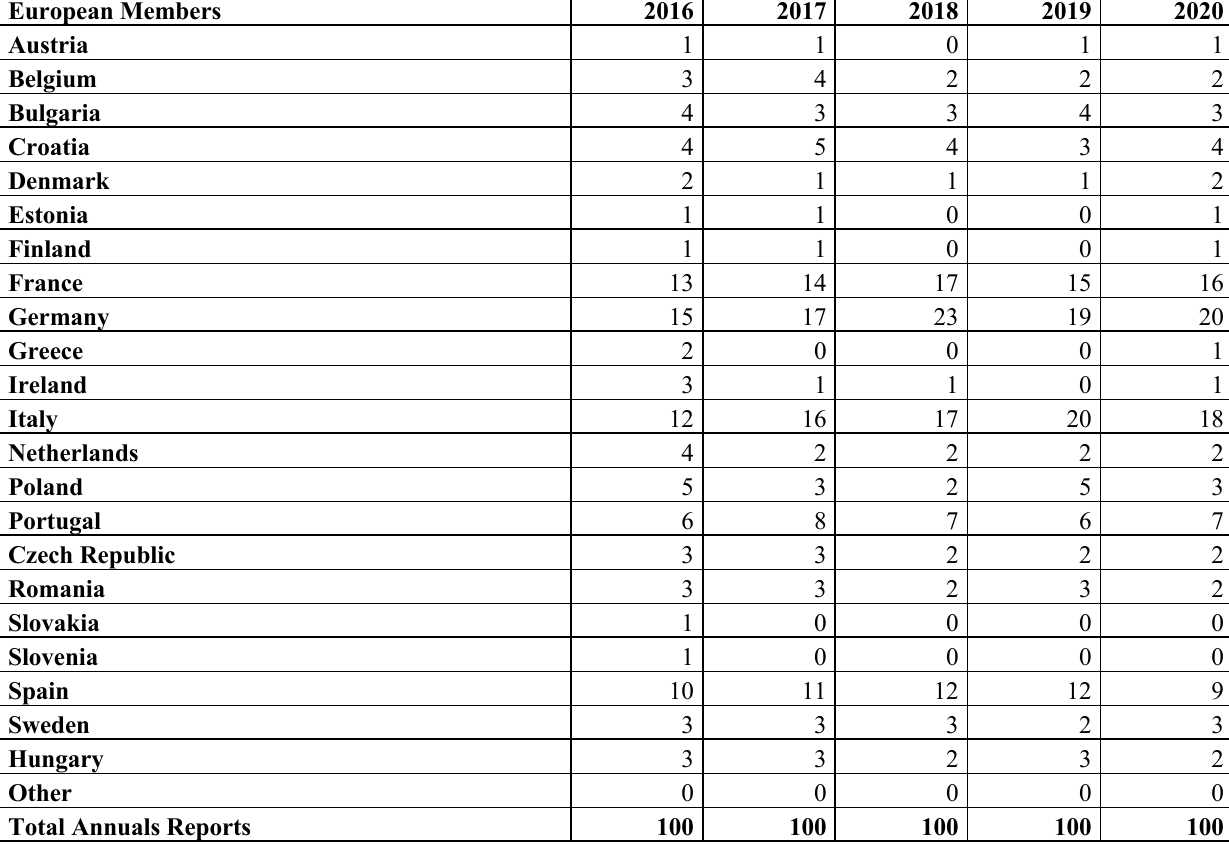
Table 1. Data sampling of European business corporation with cost of decommissioning. Materiality: substantial amounts exceeding 1 million